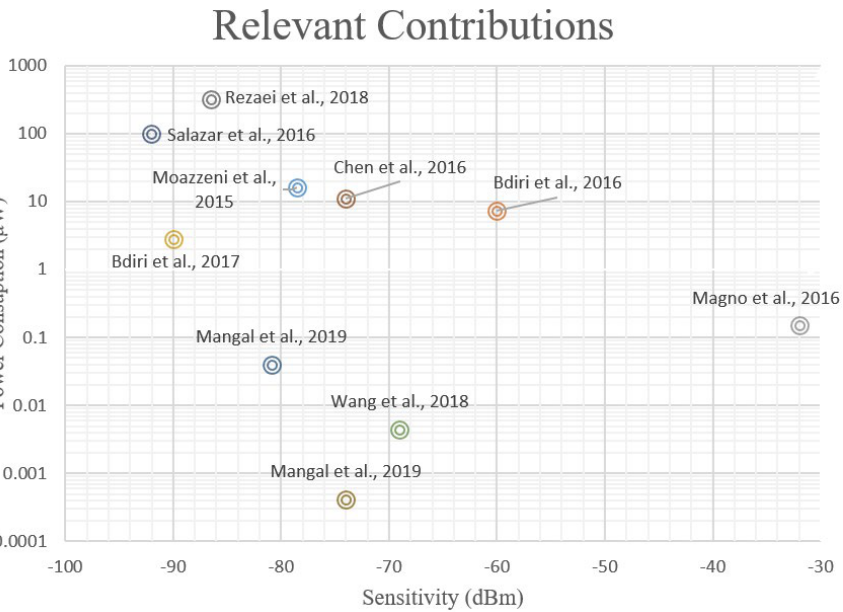
Figure 2. Representation of some of the most relevant state-of-the-art contributions in WuR design. Power consumption and sensitivity are the two most relevant parameters for WSN applications and, thus, the contributions are compared by means of these two metrics.